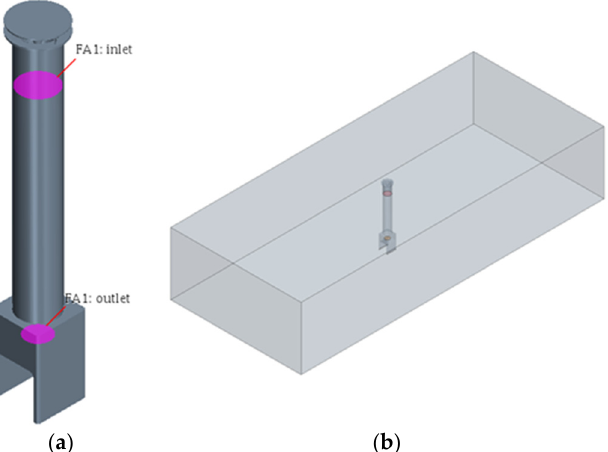
Figure 5. Analysis conditions and model. ( a ) Setup of the inlet and outlet; ( b ) FE model.